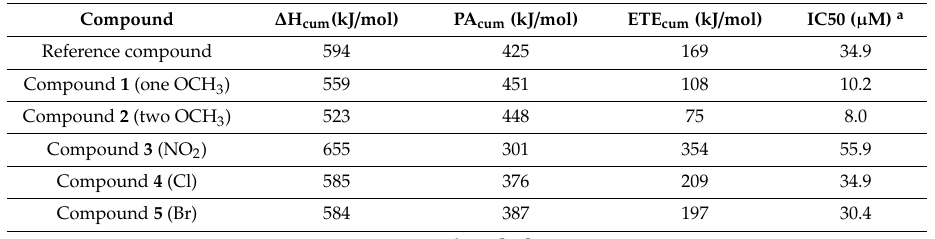
Table 6. The cumulative enthalpy values, ∆ H cum , PA cum , and ETE cum , for dendritic antioxidants and the experimental DPPH IC50 values.